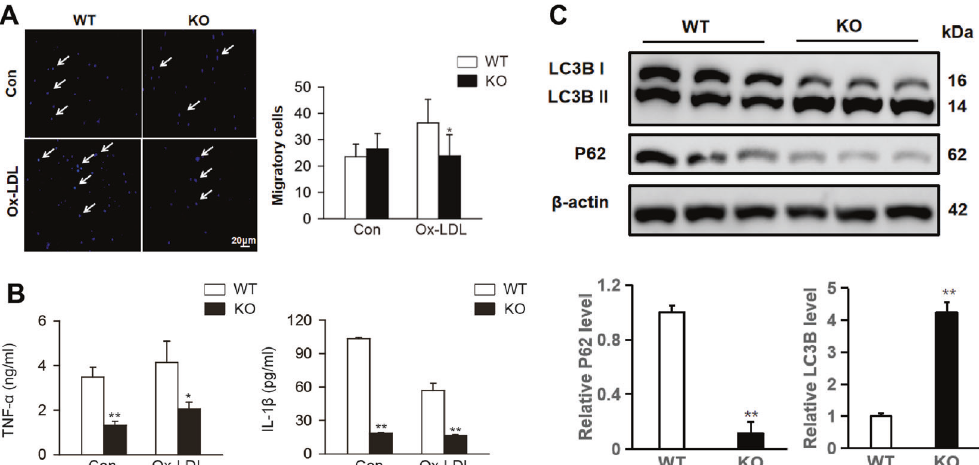
Fig. 6 Swiprosin-1 de fi ciency inhibited cytokine secretion and macrophage migration and promoted macrophage autophagy. A The levels of TNF- α and IL-1 β were detected by ELISA kit. Data are presented as the mean ± SE; * P < 0.05, ** P < 0.01, n = 3/group. B Primary peritoneal macrophages migration was detected by Transwell migration assay. Data are presented as the mean ± SE; * P < 0.05; n = 6/group. C Representative Western blot for autophagy-related protein (P62/SQSTM1 and LC3B) in primary peritoneal macrophages of Swp − / − and WT mice after stimulated with ox-LDL for 24 h (upper) and densitometric analysis (down). β -Actin served as the loading control. Data are presented as the mean ± SE; ** P < 0.01. The result was repeated in at least three independent